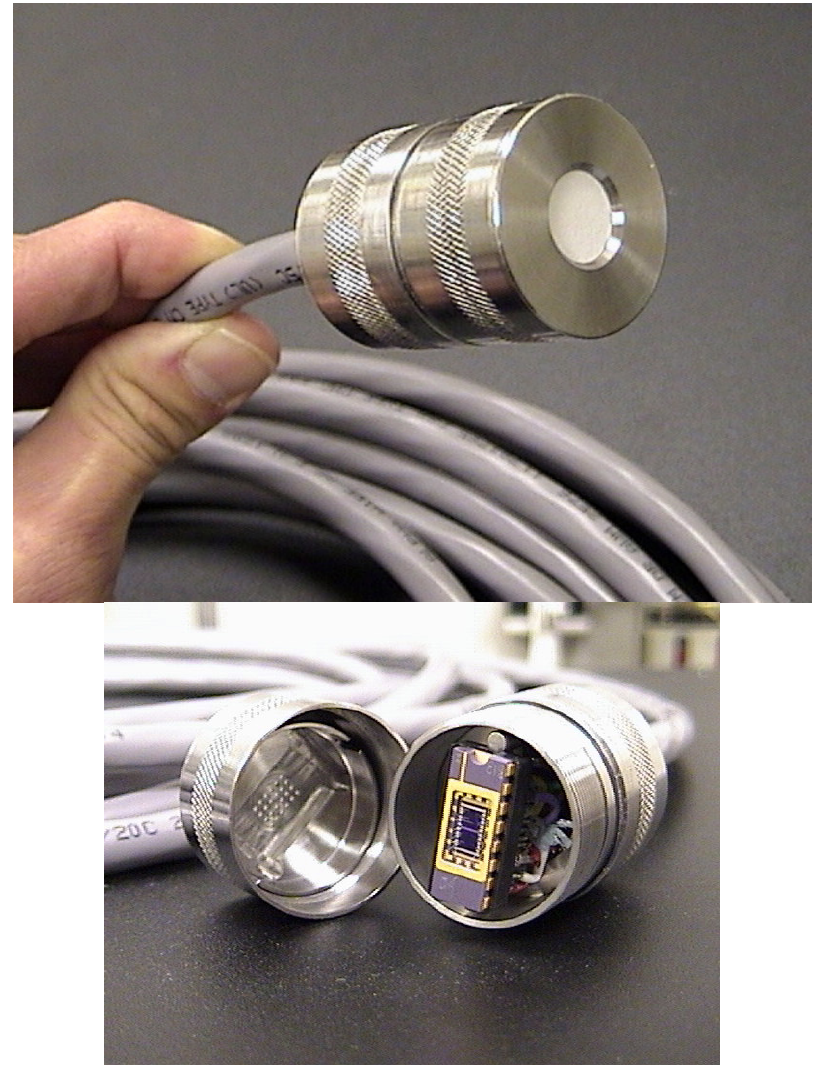
Figure 5. Stainless-steel waterproof package that houses the chemiresistor array. Left: GORE-TEX ® membrane covers a small window over the chemiresistors. Right: Disassembled package exposing the 16-pin dual-in-line package and chemiresistor